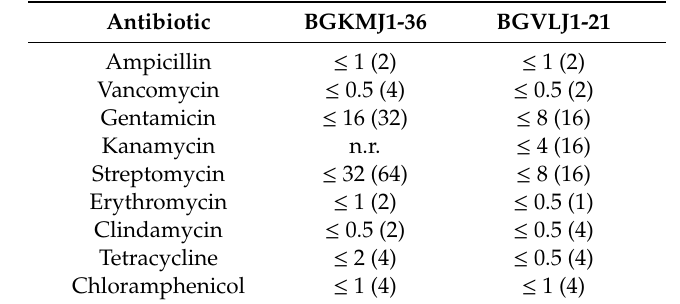
Table 3. Minimal Inhibitory Concentrations (MIC) of Nine Antibiotics on Streptococcus thermophilus BGKMJ1-36 and Lactobacillus bulgaricus